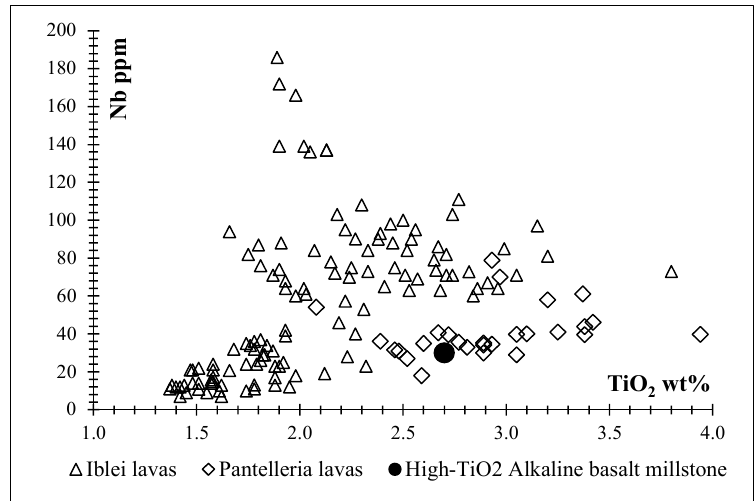
Figure 8. TiO 2 vs. Nb diagram comparing the high-TiO 2 alkaline basalt millstone with the Iblei and Pantelleria lavas (literature data from [49]).